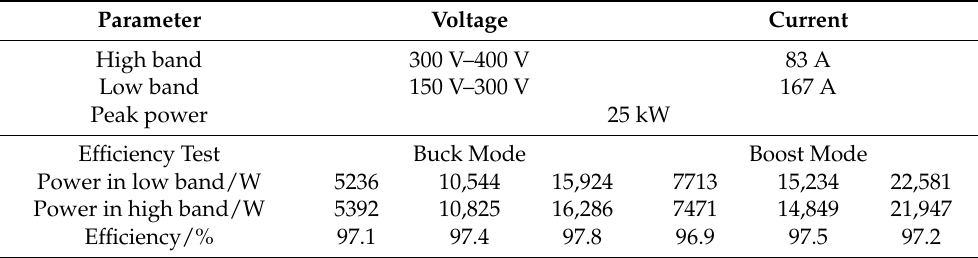
Figure 15. Structure of reversible boost DC/DC. IGBT: insulated gate bipolar transistor. Table 6. Characteristics of the reversible boost bridge DC/DC. Table 6. Characteristics of the reversible boost bridge DC/DC.